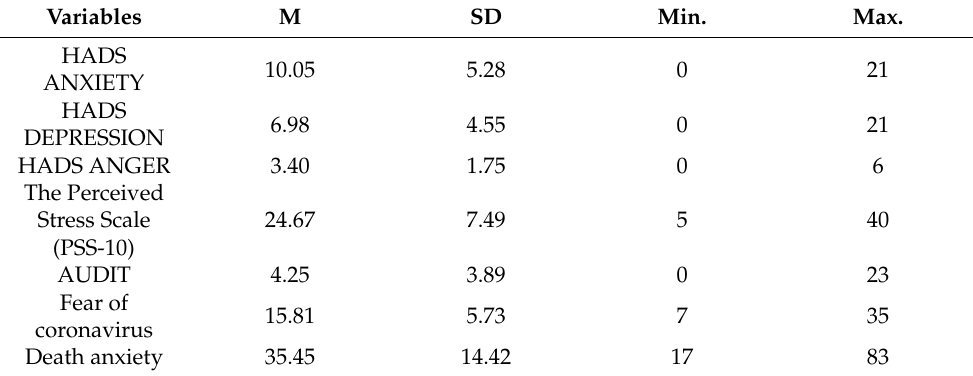
Table 5. The state of mental health and the level of perceived stress and AUDIT in the study group.